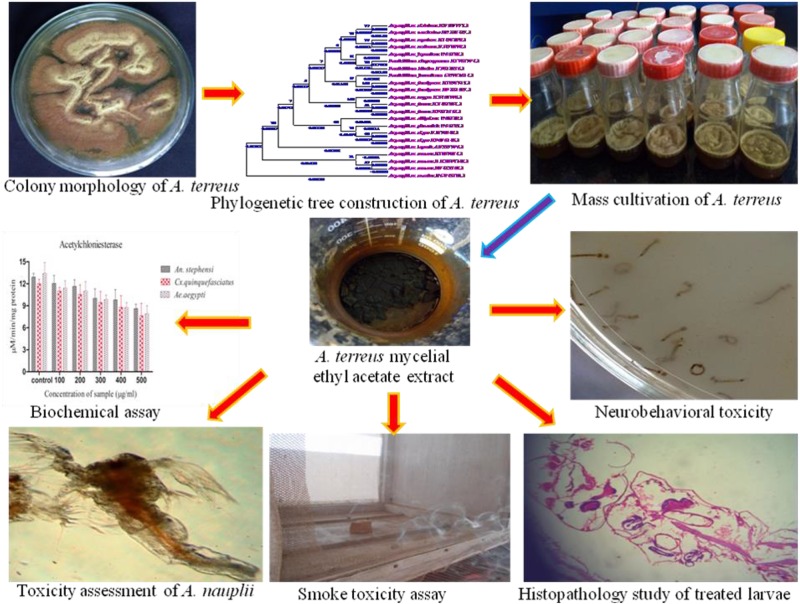
Schematic representation of overall study.